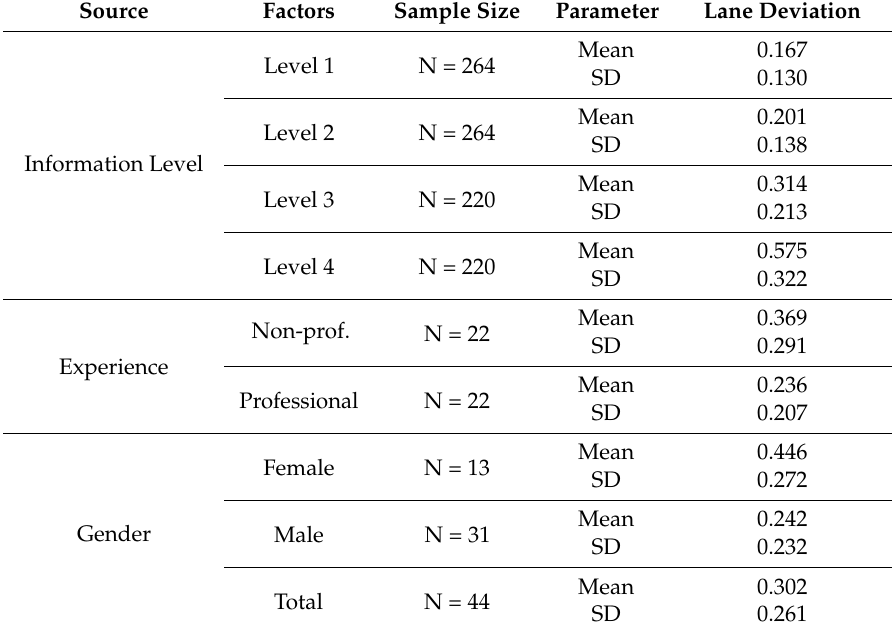
Table 8. Descriptive statistical results for lane deviation under workloads.